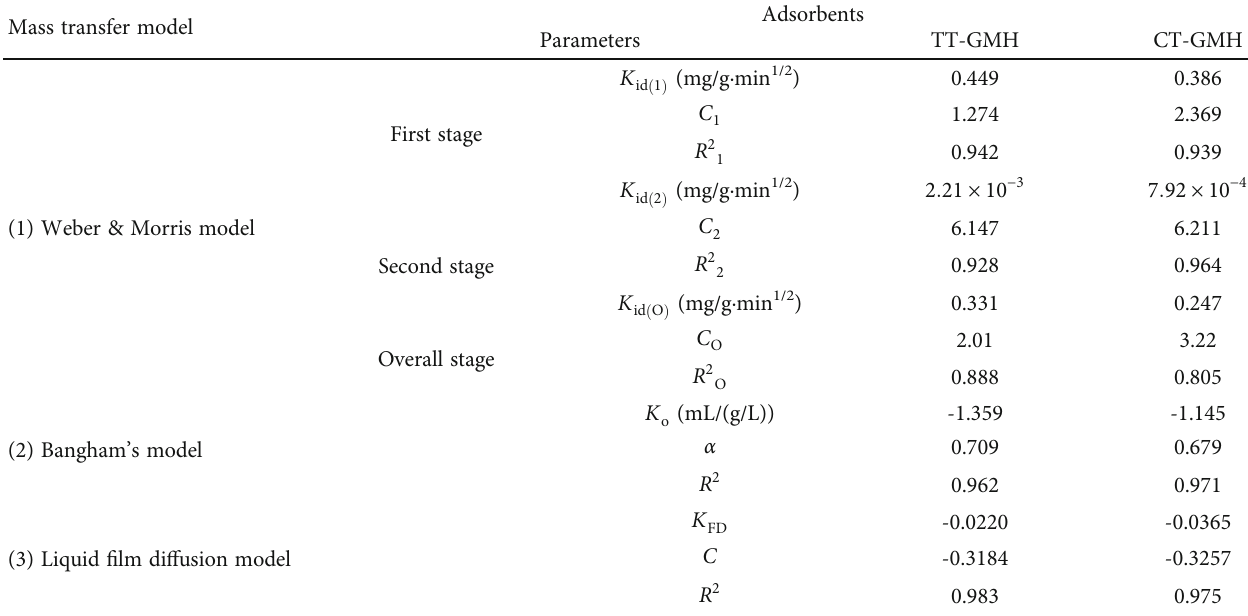
Table 5: Mass transfer parameters for adsorption of Cr(VI) on TT-GMH and